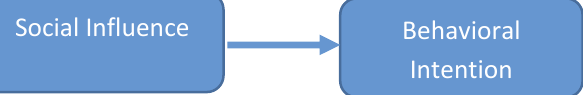
Fig. 3. Social Relationships Influence and Behavioral Intention Source (Tahrini, 2015)